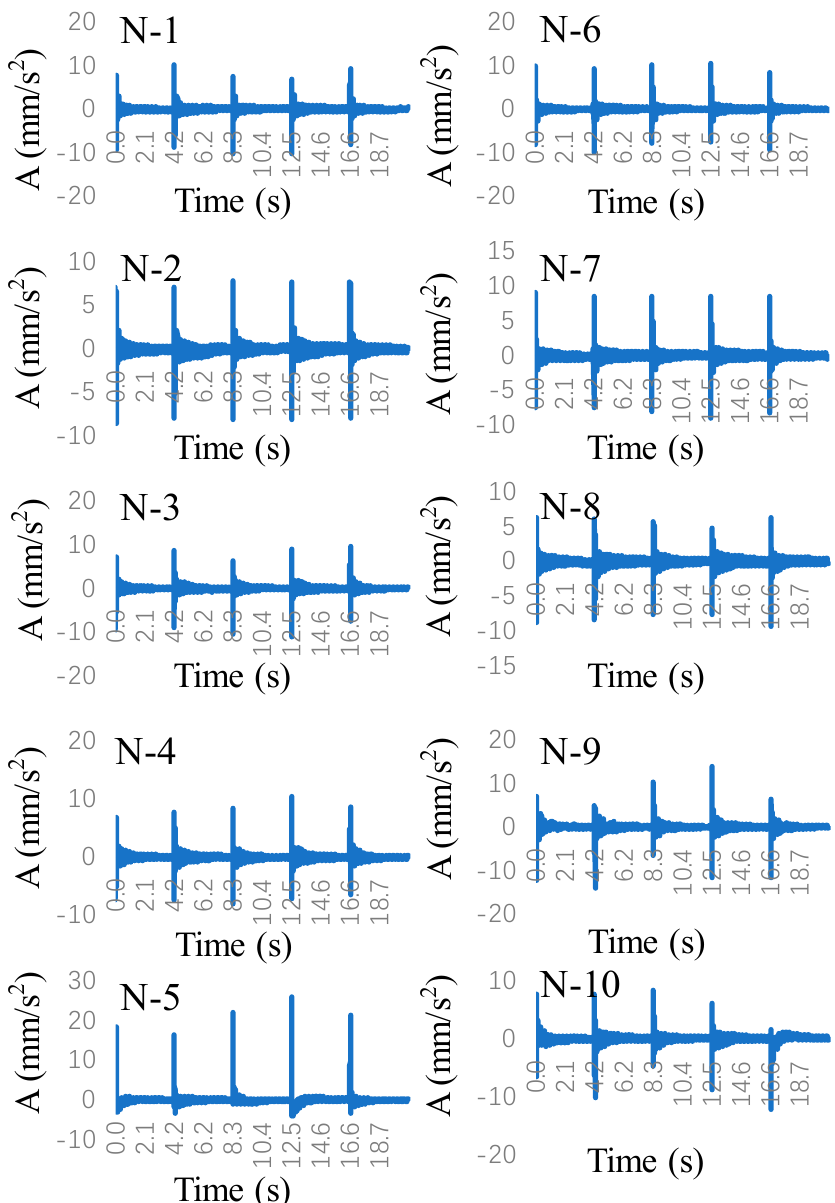
Figure 8. The time-history curve of acceleration. A: Acceleration. Figure 9 is the displacement time-history curve of 10 nodes of the intact structure, which was obtained by the DIC method from 5120 pictures captured by the high-speed camera.